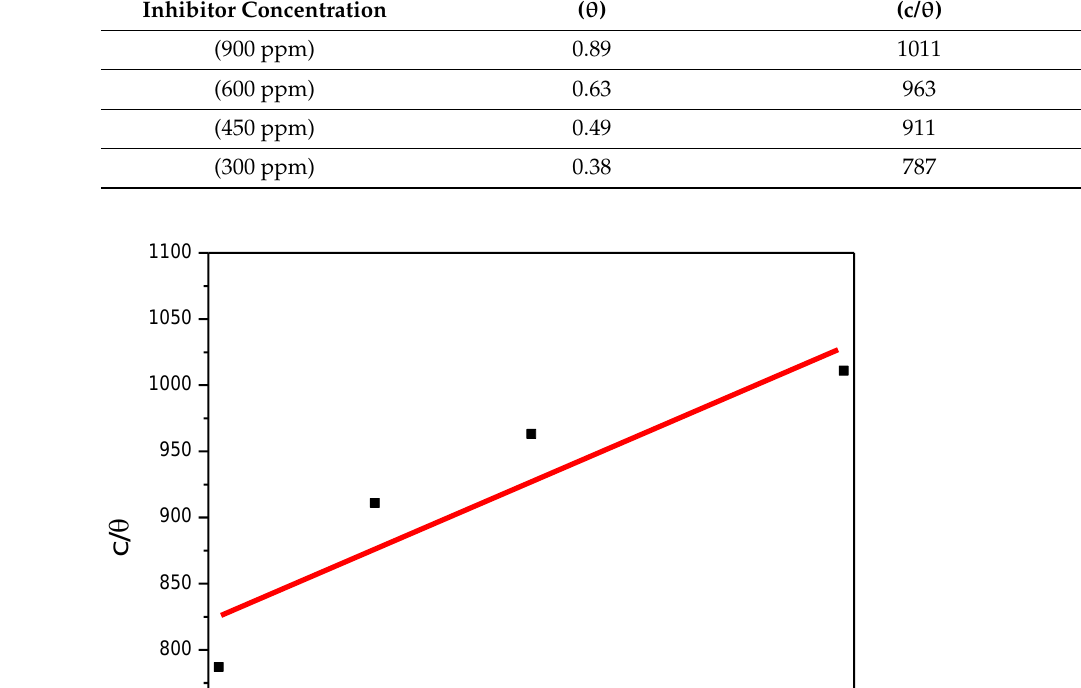
Table 8. (c/ θ ), ( θ ), and c values as determined from Table 5. Inhibitor Concentration